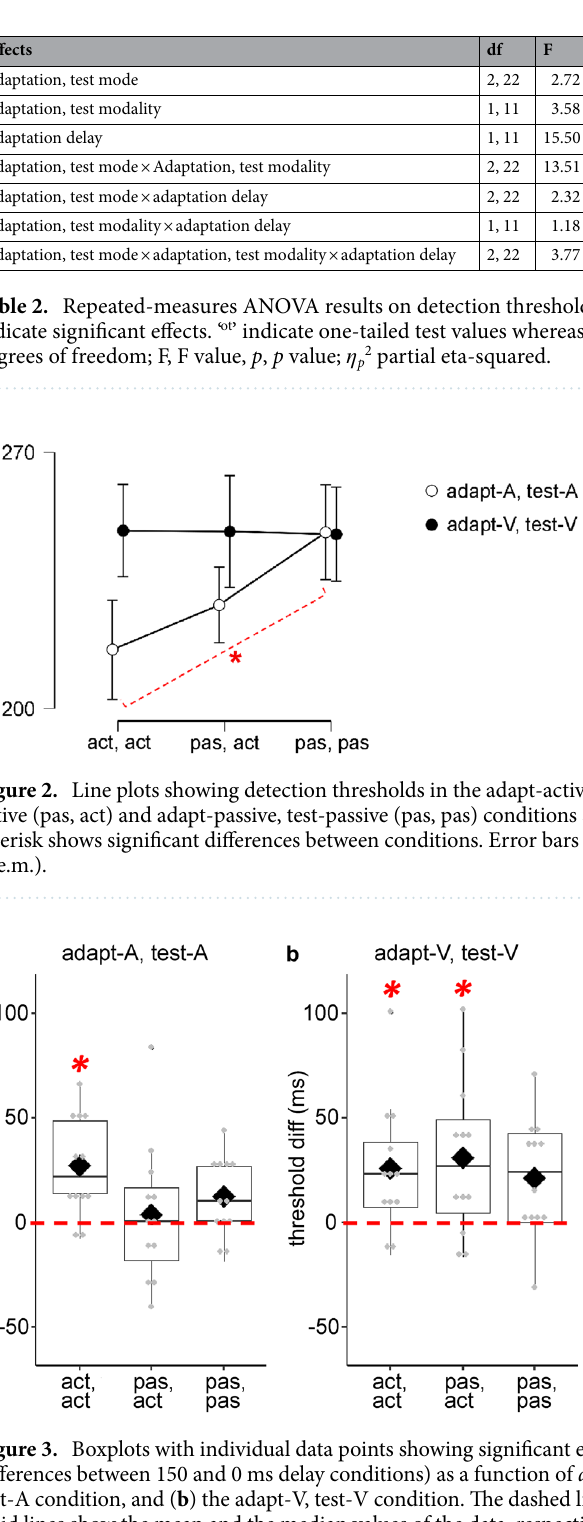
The 3 ( adaptation, test mode : adapt-active, test-active vs. adapt-passive, test-active vs. adapt-passive, test- passive) × 2 ( adaptation, test modality : adapt-A, test-A vs. adapt-V, test-V) × 2 ( adaptation delay : 0 ms vs. 150 ms) repeated measures ANOVA on JNDs resulted in no significant differences across conditions (see Table 4). Together, the results suggest a shift in the detection thresholds as a function of adaptation delay for the visual